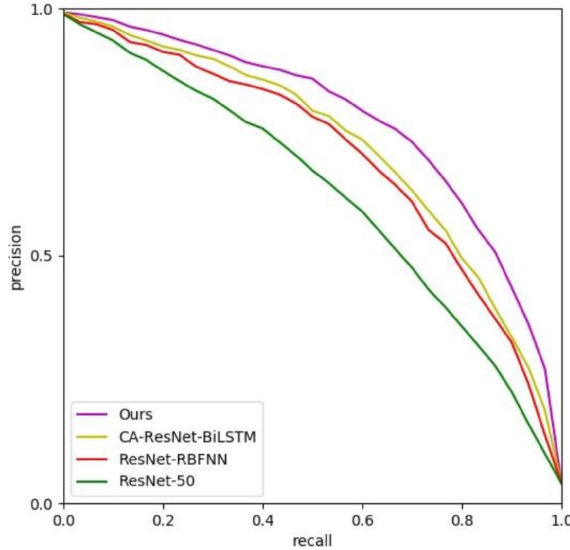
Figure 12. Average precision–recall curves on